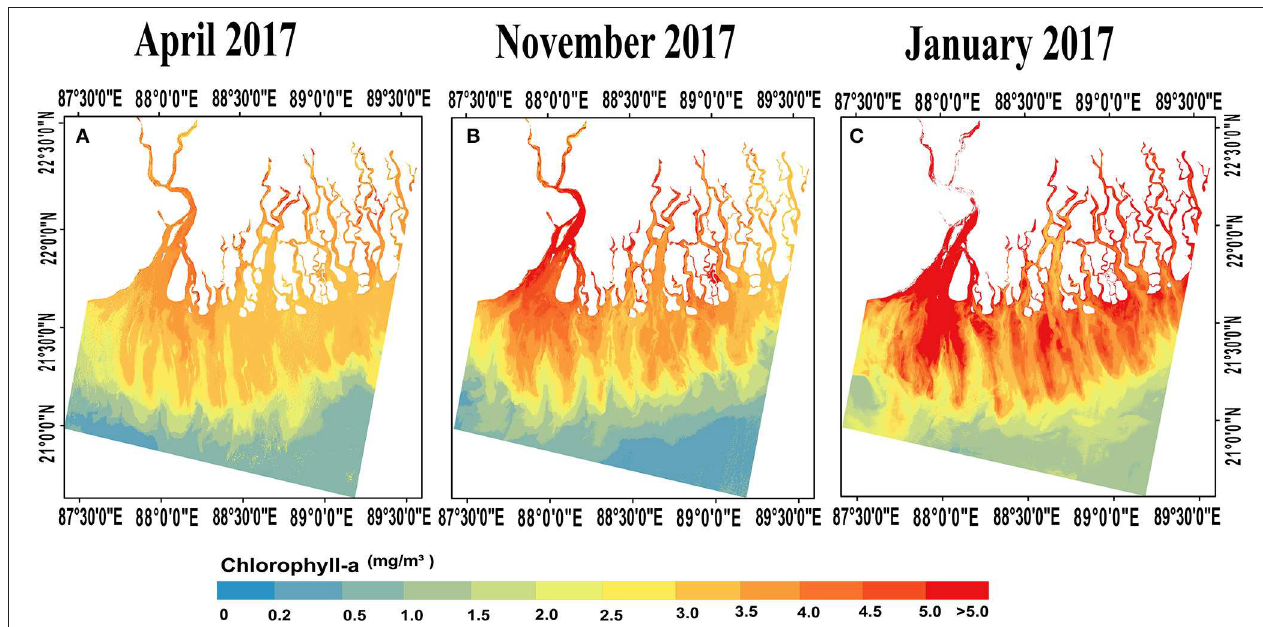
FIGURE 3 | Distribution of Chl- a retrieved from Landsat-8 OLI using the OC-2 algorithm in the northern coastal Bay of Bengal during the year 2017 for (A) pre-monsoon (April), (B) post-monsoon (November), and (C) winter-monsoon (January).